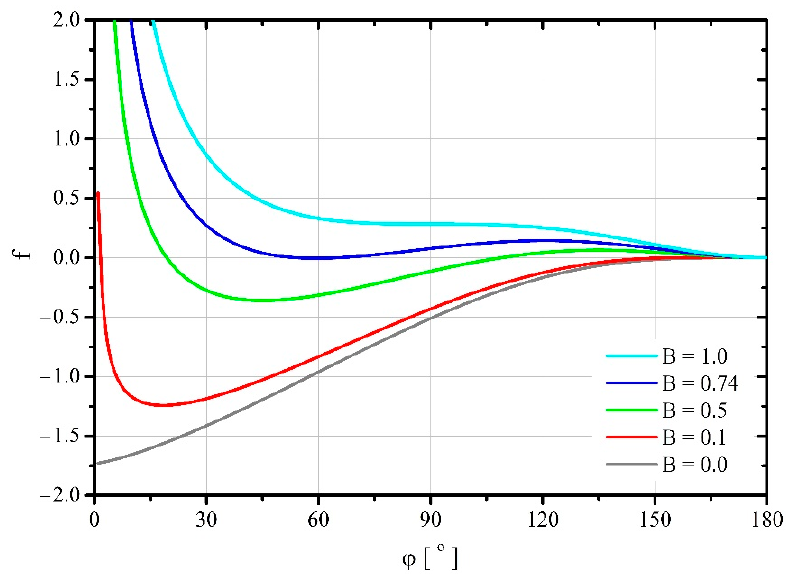
Figure 2. Changes in the dimensionless free energy of a spherical droplet during its spreading on a solid surface—the Young case.